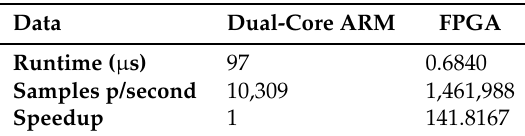
Table 3. ANNM runtime.